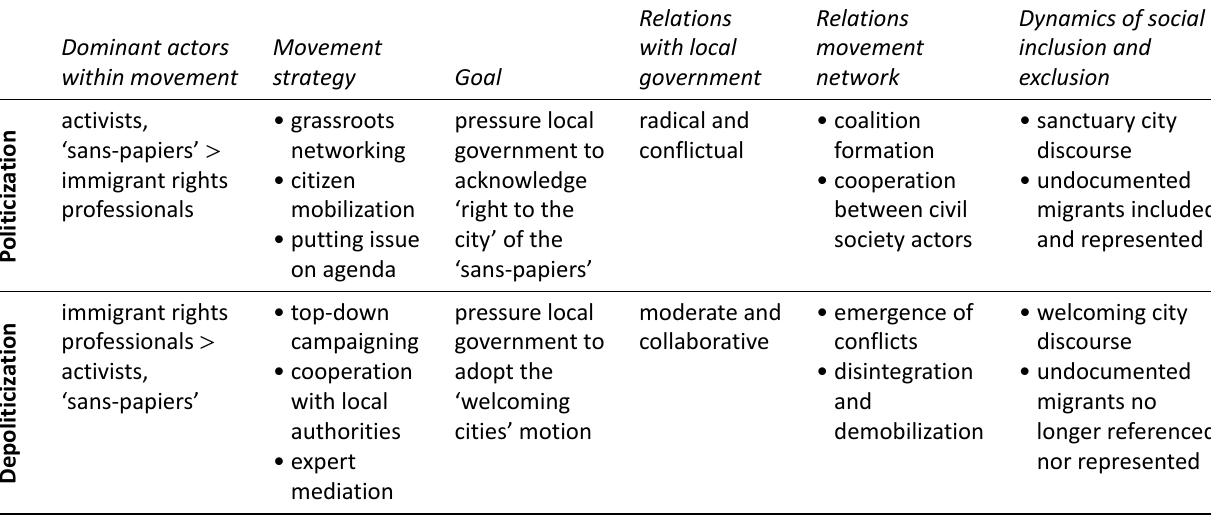
Table 1. The dual process of politicization and depoliticization in sanctuary